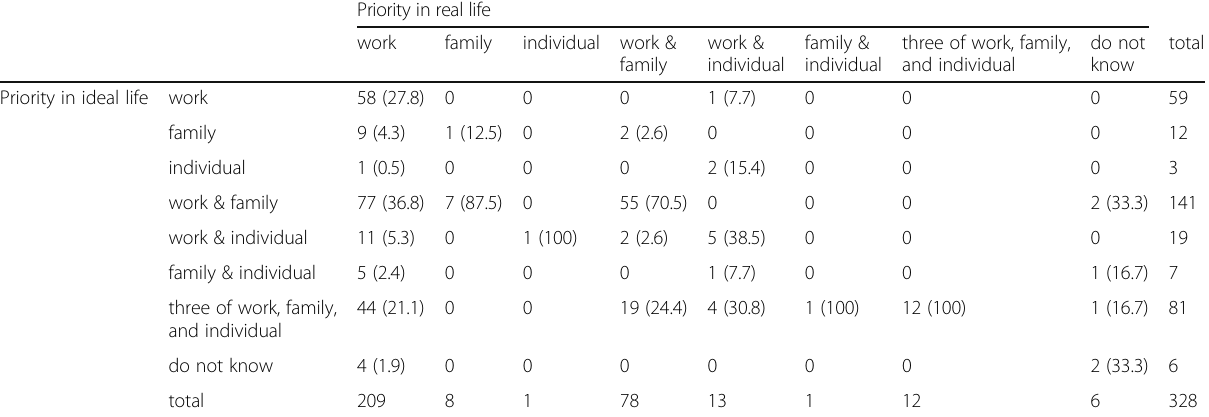
Priority in real life work family individual work &